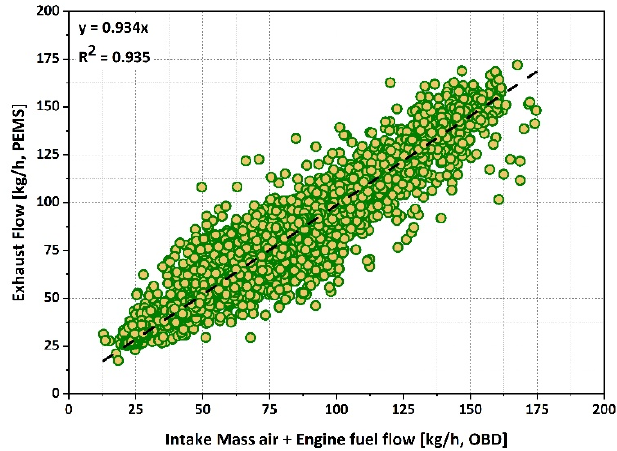
Figure 7. Correlation of exhaust flow measured by the PEMS and SEMS equipment.